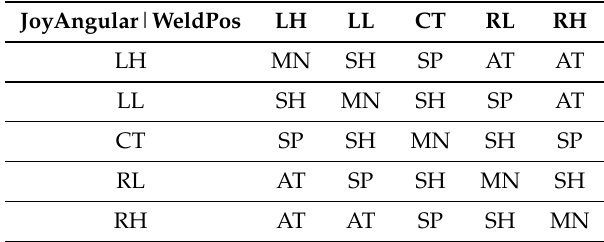
Table 2. Rules for angular velocity and weld position.